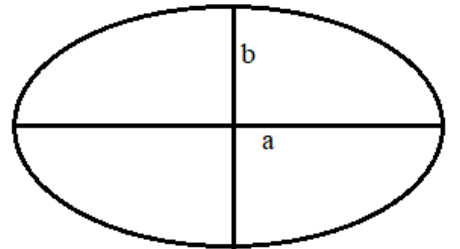
Figure 17. Added mass coefficient of egg-shaped body.